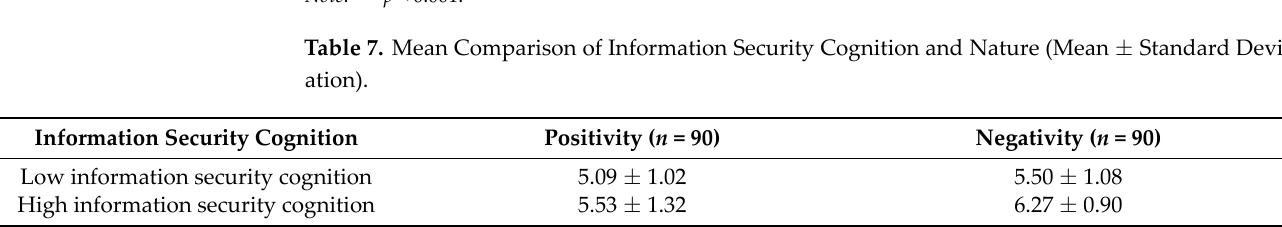
Table 7. Mean Comparison of Information Security Cognition and Nature (Mean ± Standard Devi- ation).